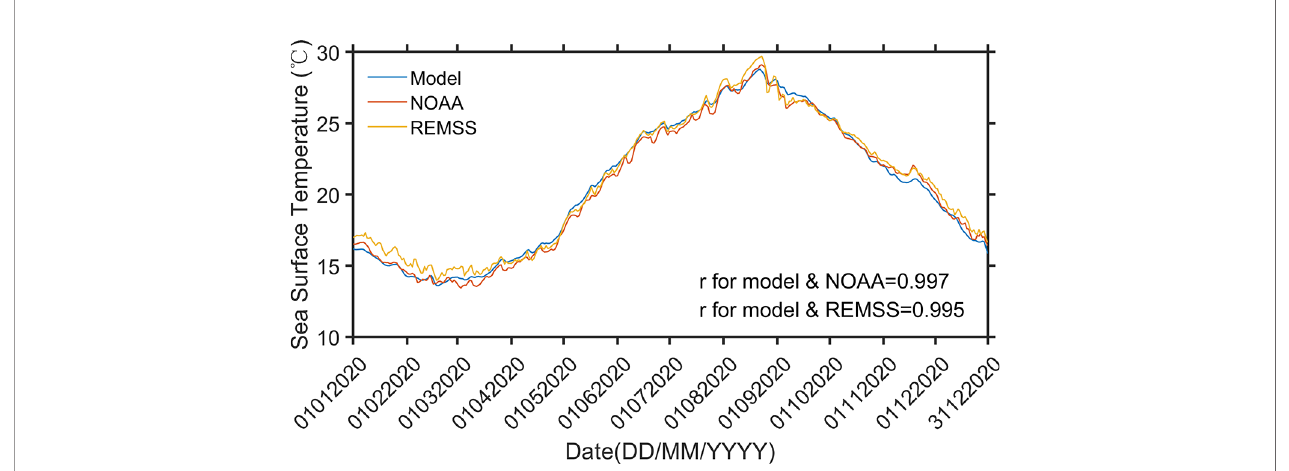
FIGURE 2 | Averaged daily mean sea surface temperature (SST) within 121 – 127°E and 27 – 32°N from the numerical model (in this fi gure: Model), US National Oceanic and Atmospheric Administration (NOAA) Optimally Interpolated (OI) SST product (in this fi gure: NOAA), and the Remote Sensing Systems OI SST product (in this fi gure: REMSS) over time. The Pearson correlation coef fi cients between the model outputs and the observational products, r , are